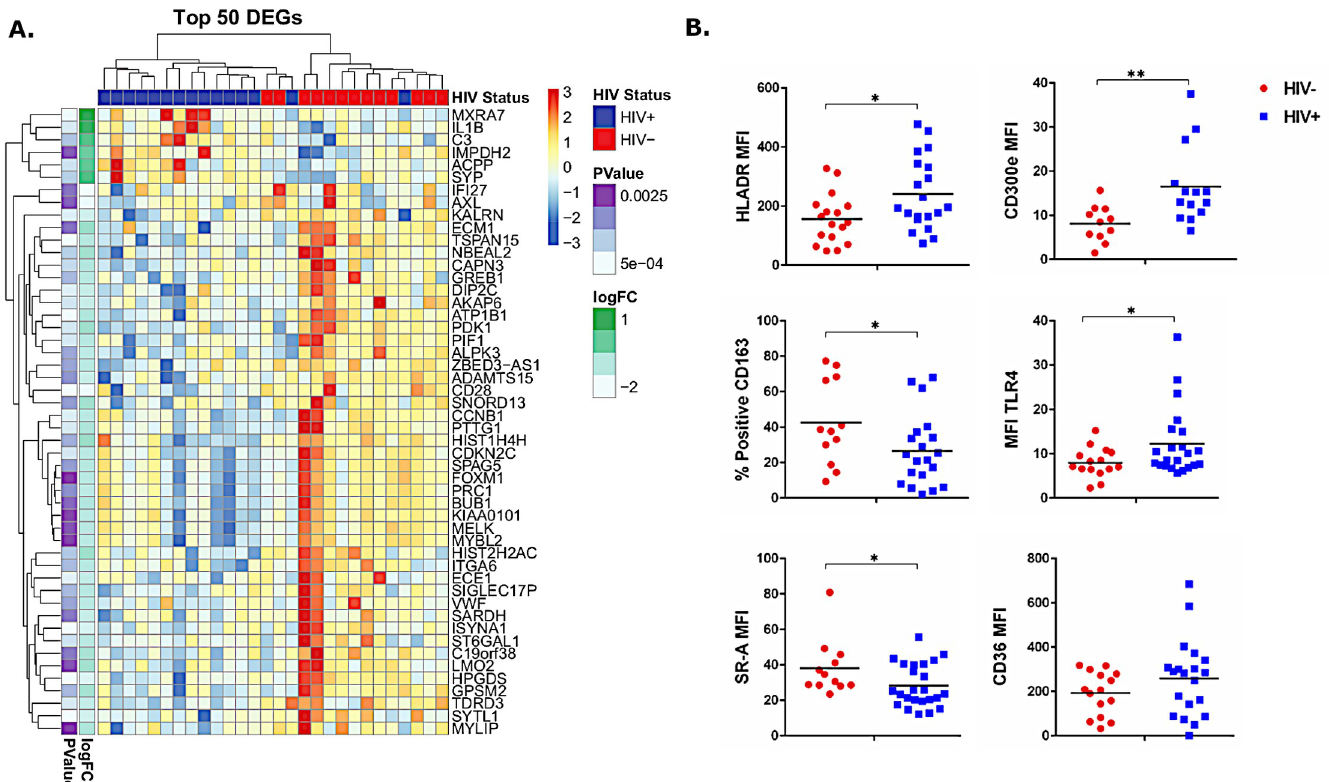
Fig 1. Altered macrophage phenotype in HIV+ individuals may contribute to vascular inflammation. A) Transcript analysis identified differentially expressed genes among macrophages obtained from donors with and without HIV. Data are arranged by p-value and log fold change (LogFC). B) Surface activation marker expression measured by flow cytometry. � p < 0.05, �� p <